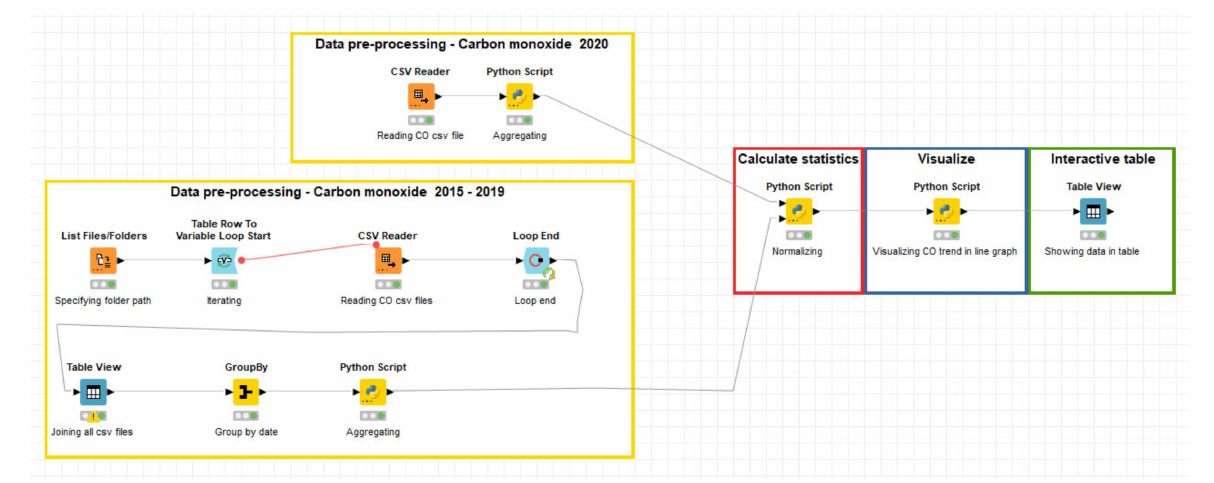
Figure 3. KNIME workflow to estimate the daily mean concentration of pollutants in California for both 2020 and 2015–2019.